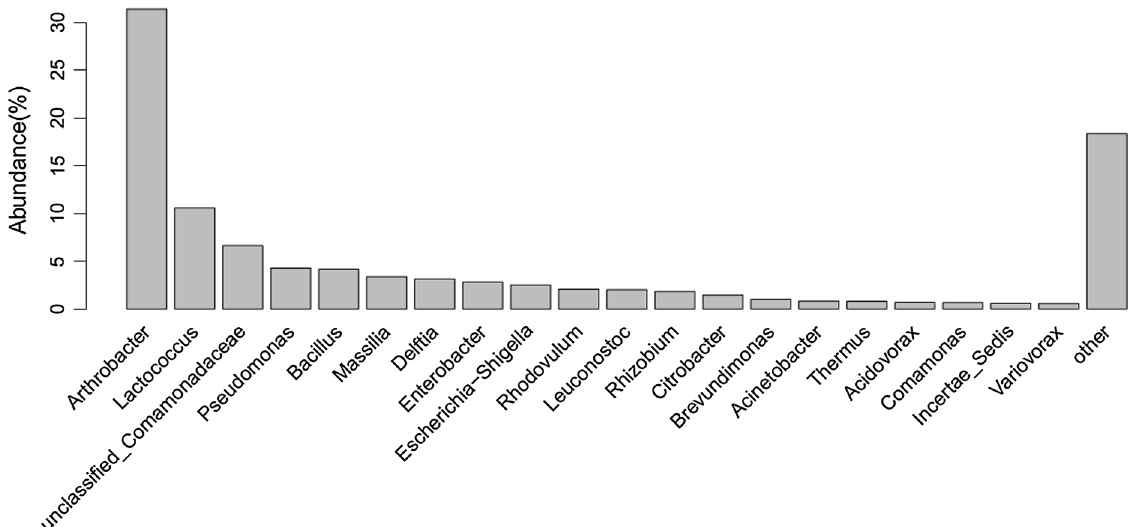
Fig. 5 Community abundance histogram of genus level in reaction